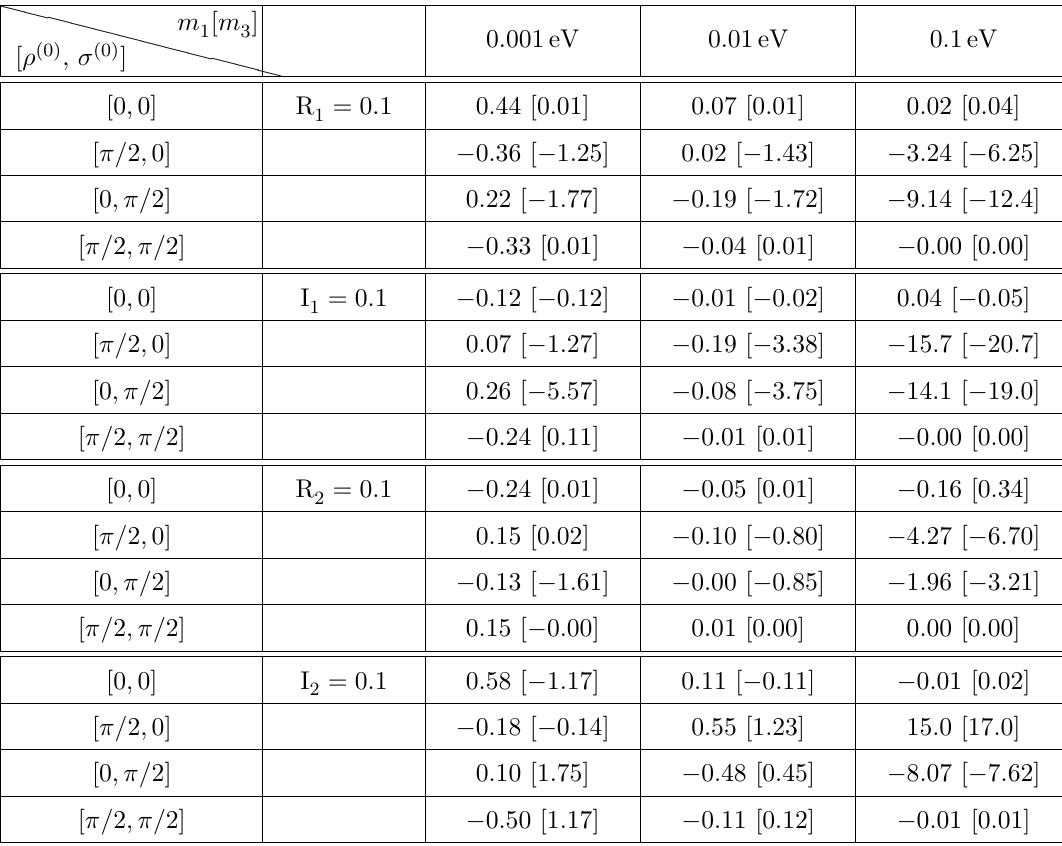
Table 3 . Some representative values of (cid:1) (cid:26) (induced by R respectively) at m (cid:26) (0) and (cid:27) (0) with (cid:14) (0) = (cid:0) (cid:25)=